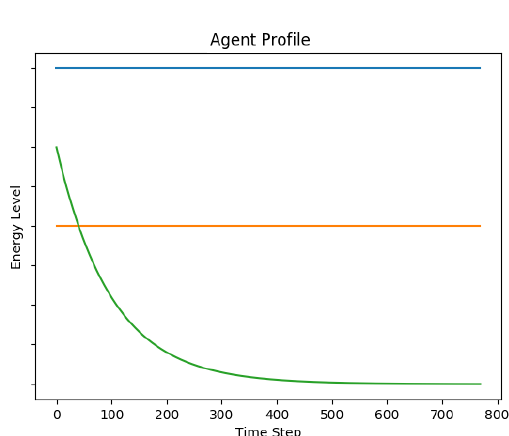
Figure 10. Typical behavior of the variable controlled by the agent A3CERG. The green line indicates the variable evolution. The orange and blue lines indicate the variable’s target range ( min,max ) . The variable’s behavior was the same consolidated in this figure, regardless of the target range